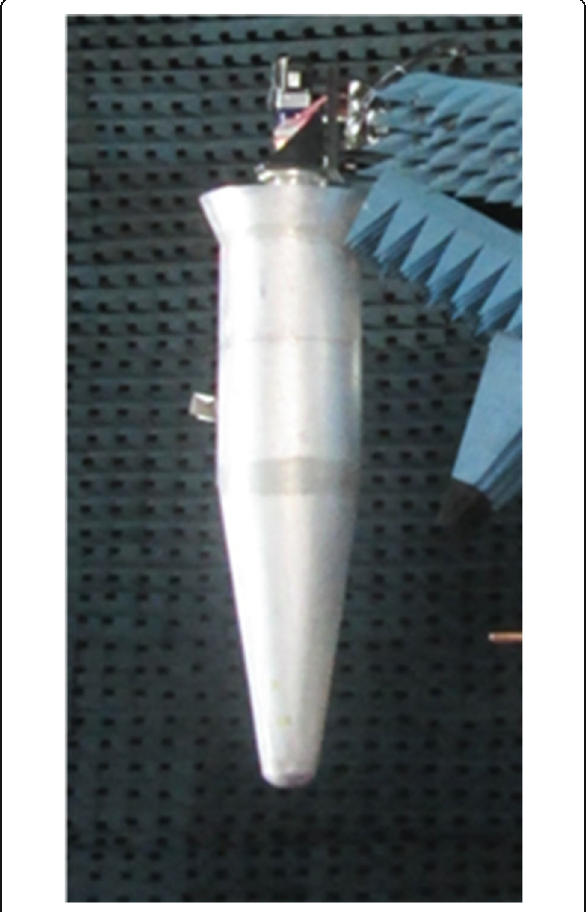
Fig. 12 The warhead model